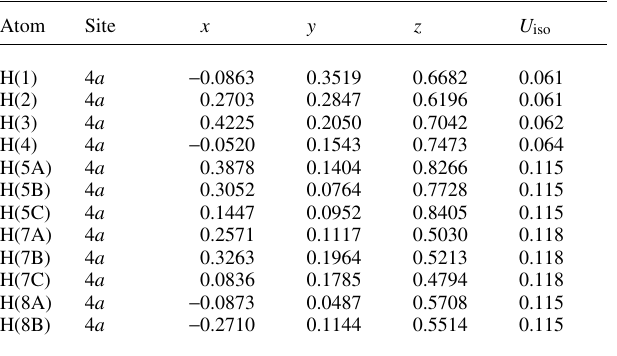
Table 2. Atomic coordinates and displacement parameters (in Å 2 ) . Table 2. Continued